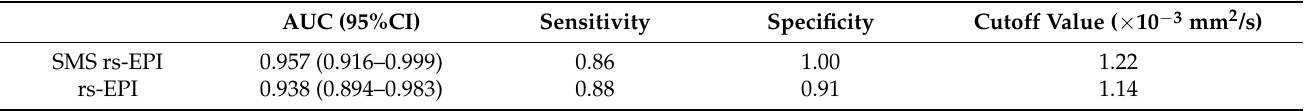
Table 4. Diagnostic efficiency of ADC value in SMS rs-EPI and conventional rs-EPI. AUC